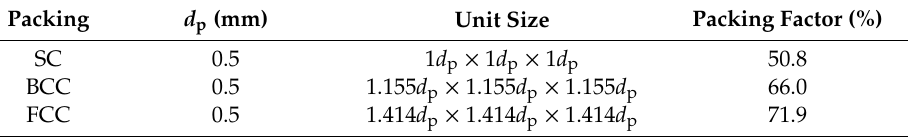
Figure 1. The ordered packing units: ( a ) simple cubic (SC) packing; ( b ) body center cubic (BCC) packing; and ( c ) face center cubic (FCC) packing. Table 1. Typical packing parameters for ordered packing units.